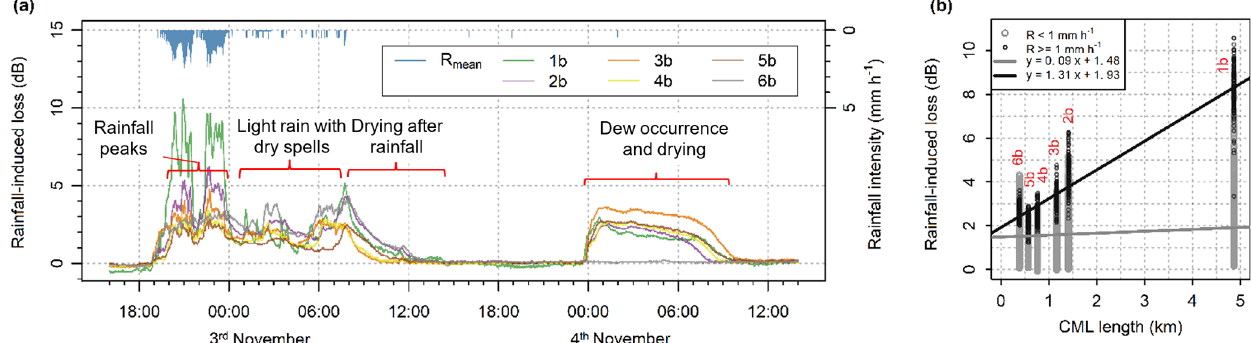
Figure 5. (a) Rainfall-induced loss of 83–84GHz sublinks and mean rainfall intensity from all four rain gauges. Period with peak rainfalls on 2 November from approx. 19:00 to 00:00UTC, period with light rainfall and dry spells on 3 November from approx. 00:00 to 05:00UTC, antenna drying period on 3 November from approx. 08:00 to 14:00UTC, and dew occurrence and subsequent antenna drying on 4 November from approx. 00:00 to 10:00UTC. (b) Rainfall-induced loss plotted against path length for 83–84GHz sublinks with two separate linear fits for intervals with moderate rainfall and intervals with very light rainfall including dry spells. Period from 19:00UTC on 2 November to 14:00UTC on 3 November is shown.